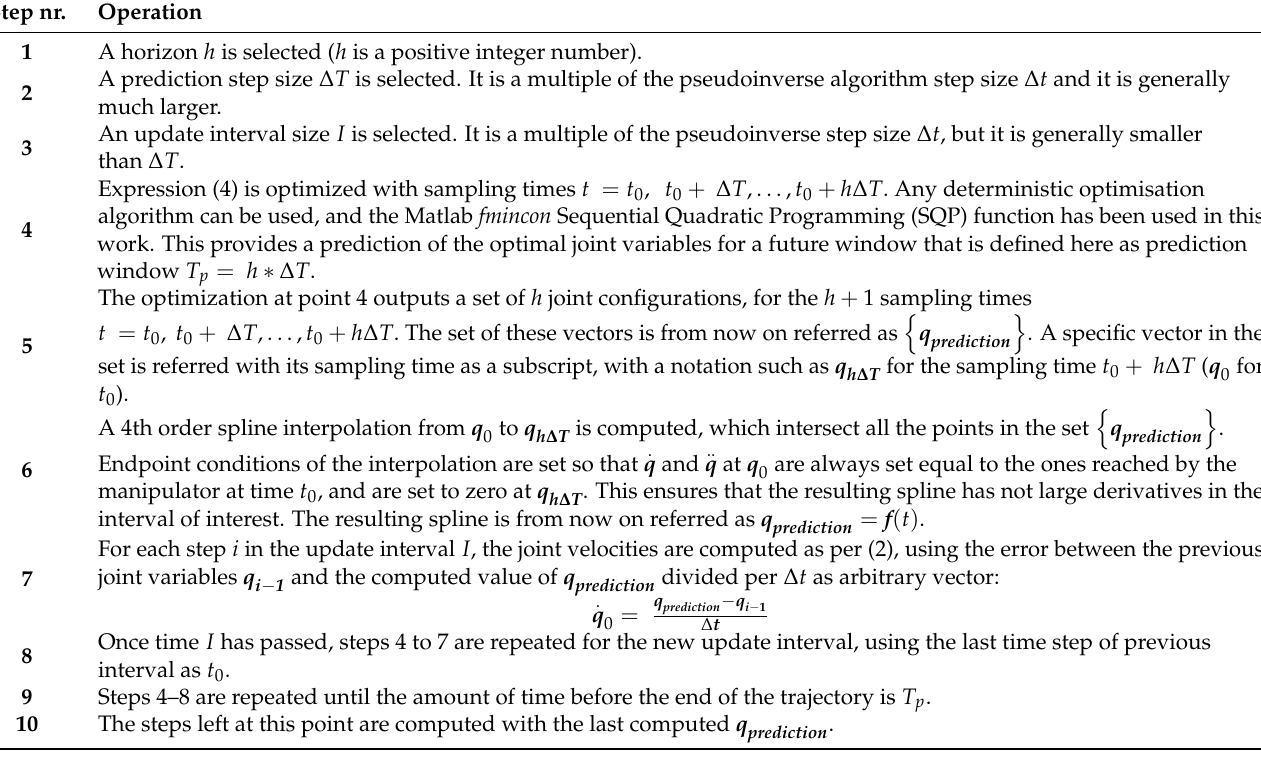
Table 1. Steps of the Predictive Minimization of Kinetic Energy (PMKE)